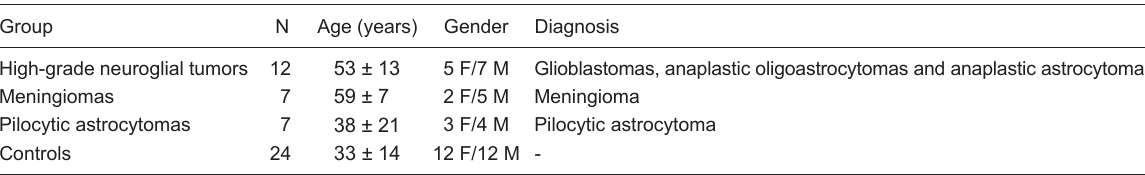
Table 1. Demographic data of controls and patients with brain tumors.